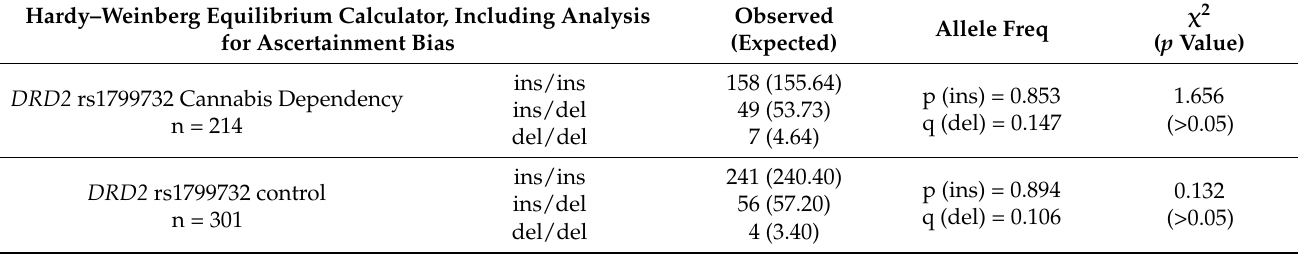
Table 1. Hardy–Weinberg’s law for patients diagnosed with polysubstance use disorder comorbid with a depressive episode Cannabis Dependency and control